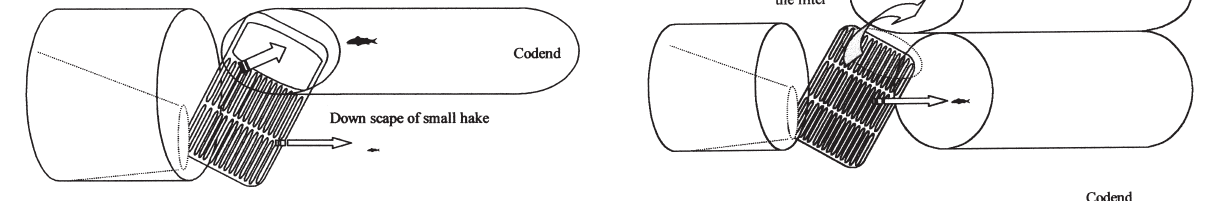
F IG . 2. – Scheme of grid B, device for big fishes on top (20 mm bar separation) (Fig.